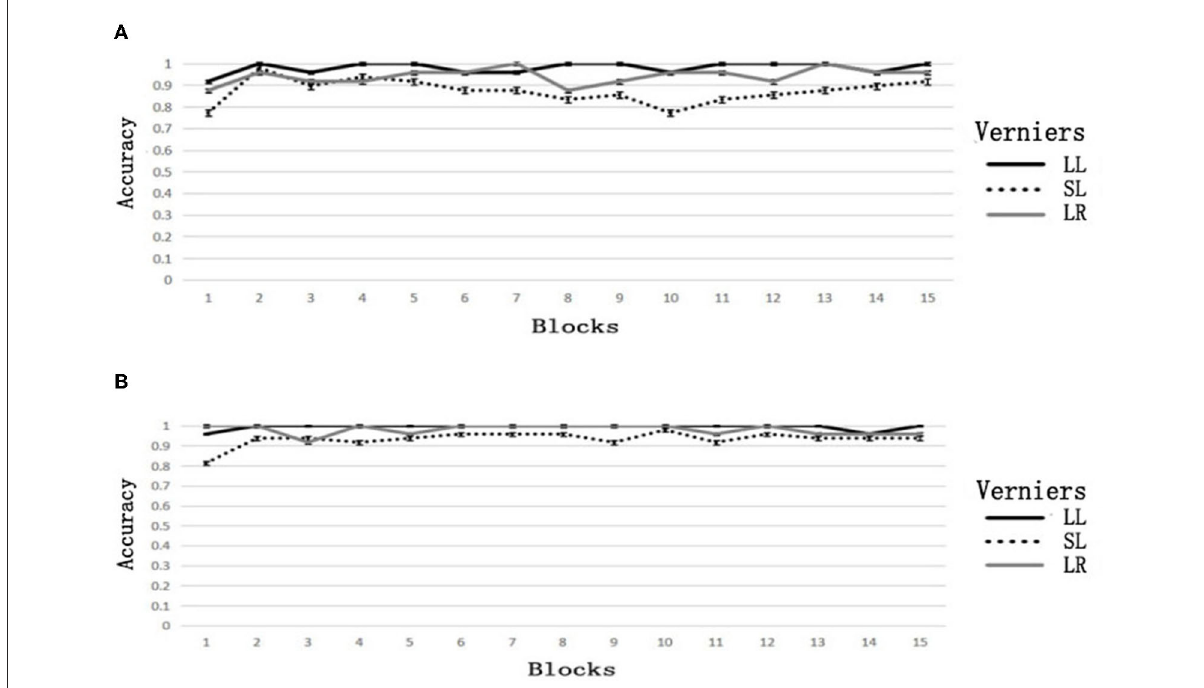
FIGURE3 Accuracy of block feedback. (A) Biased feedback, (B) consistent feedback.